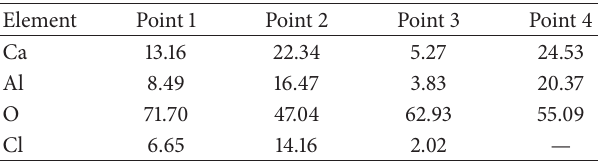
Table 2: Results of EDX analysis for elemental composition of origi- nal hydrocalumite and regenerated samples (in atomic percent). The locations where the EDX analyses were made are shown in Figure 4 (points 1, 2, 3, and